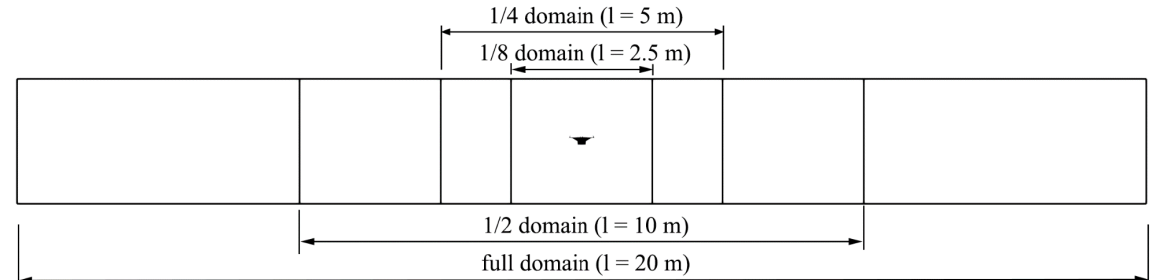
Figure 17. Domain sizes considered in the domain sensitivity study.